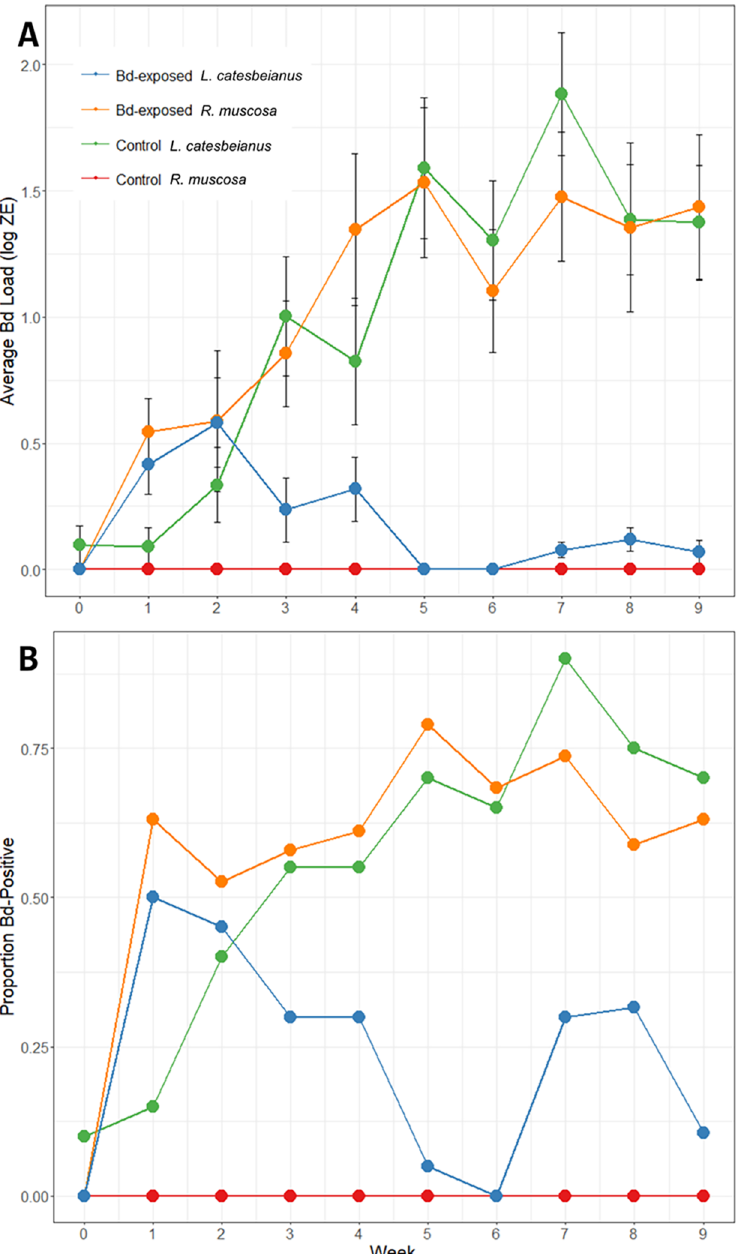
Fig 2. Bd prevalence and intensity across all treatment groups throughout the experiment. (A) Average Bd load, measured as log Bd zoospore equivalents (ZE) from qPCR of skin swabs, for each treatment group over the duration of the experiment. Error bars are standard error of the mean. (B) Proportion of individuals in each treatment group that were positive for Bd (ZE > 0.01) every week for the duration of the